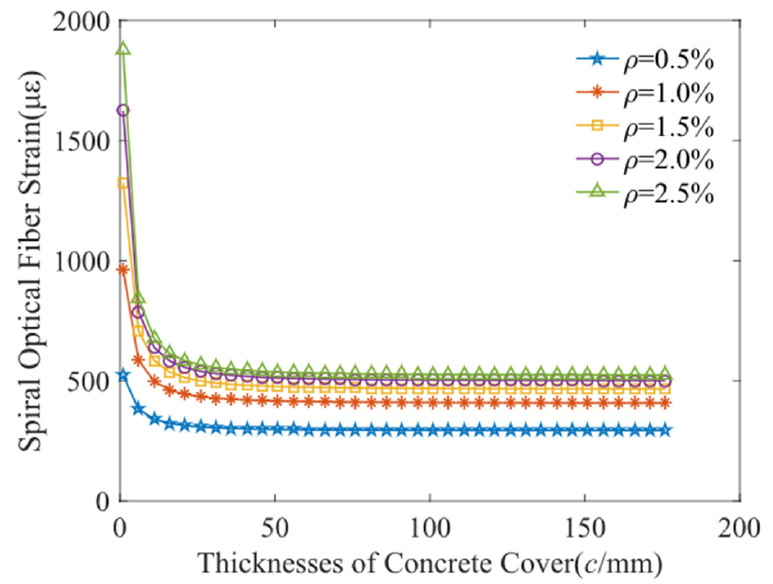
Figure 4. Fiber strain response with protective layer thickness.